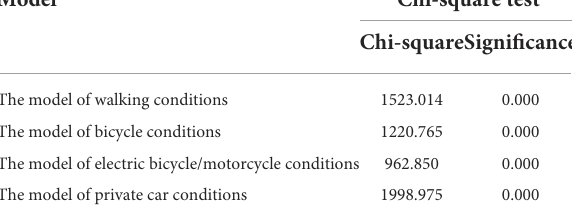
TABLE 4 Likelihood ratio test for independent